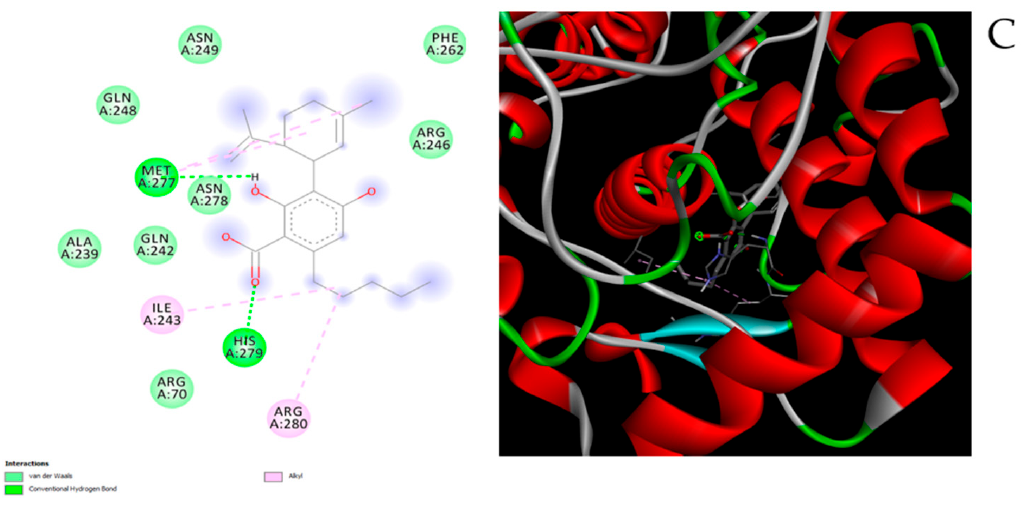
Figure 11. ( A ) Putative interactions between rutin and tyrosinase (PDB: 5I3B). Free energy of binding ( ∆ G) and affinity (Ki) are − 8.3 kcal/mol and 0.8 µ M, respectively; ( B ) putative interactions between cannabidiolic acid and tyrosinase (PDB: 5I3B). Free energy of binding ( ∆ G) and affinity (Ki) are − 6.3 kcal/mol and 24.4 µ M, respectively. ( C ) Putative interactions between cannabidiol and tyrosinase (PDB: 5I3B). Free energy of binding ( ∆ G) and affinity (Ki) are − 6.2 kcal/mol and 28.9 µ M, respectively.